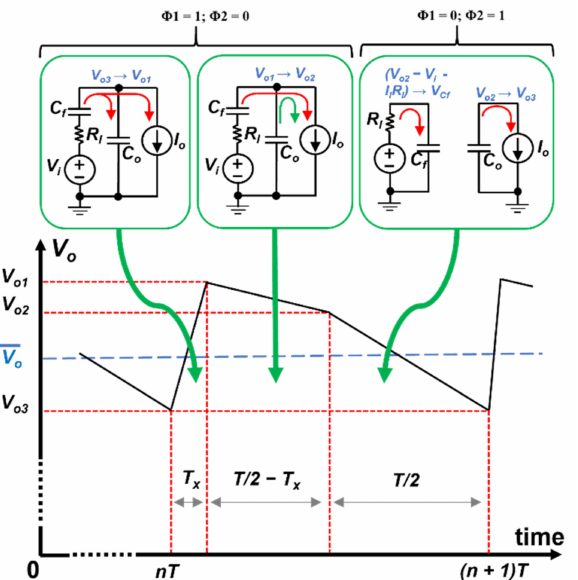
Figure 3. Output waveform and corresponding RC circuits of 1-stage linear charge